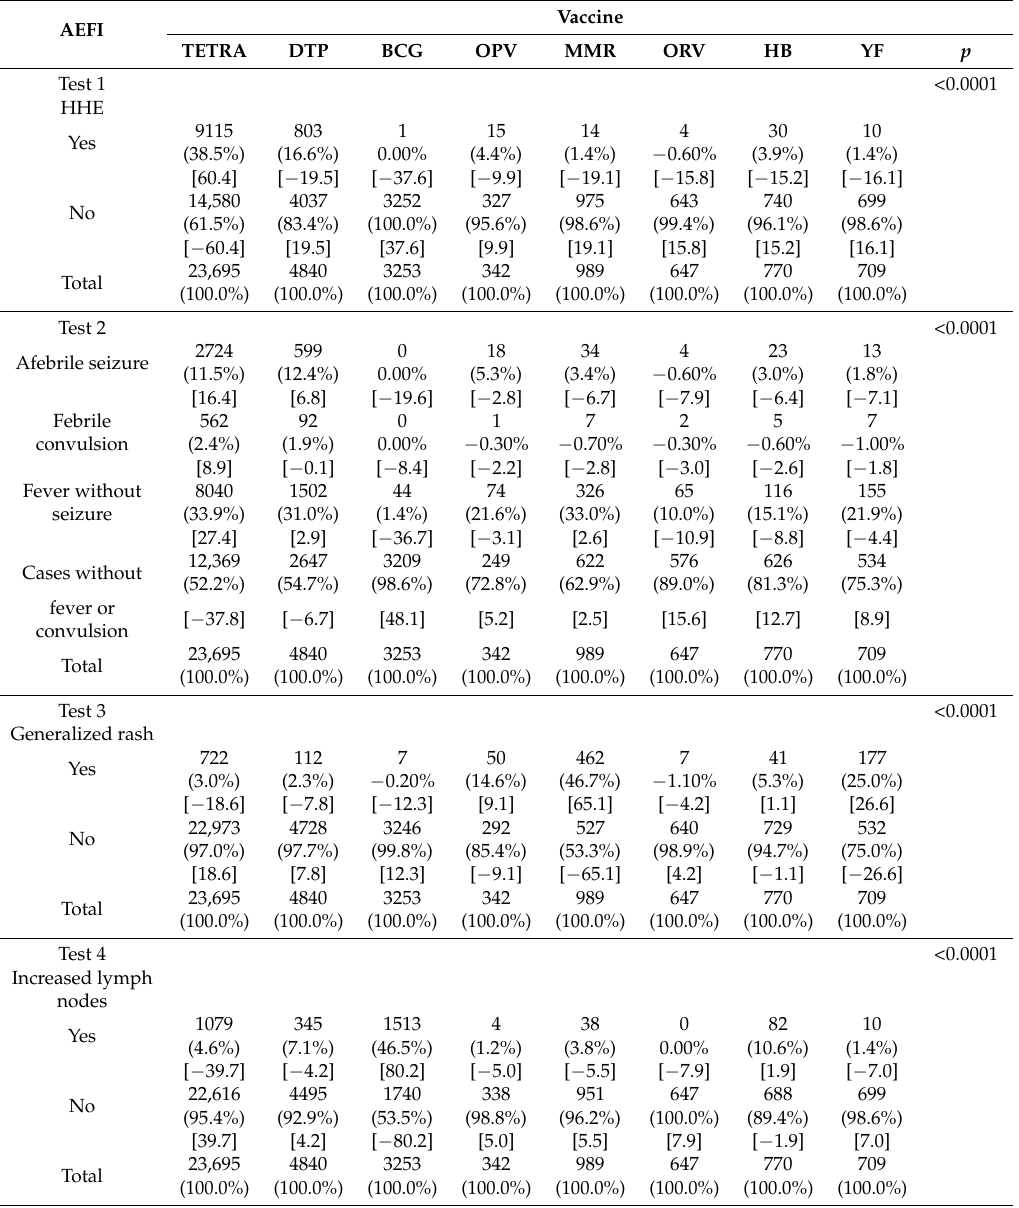
Table A1. Adjusted residuals analysis for association estimates between vaccines and the 10 most reported adverse events (considering only single inoculation doses).